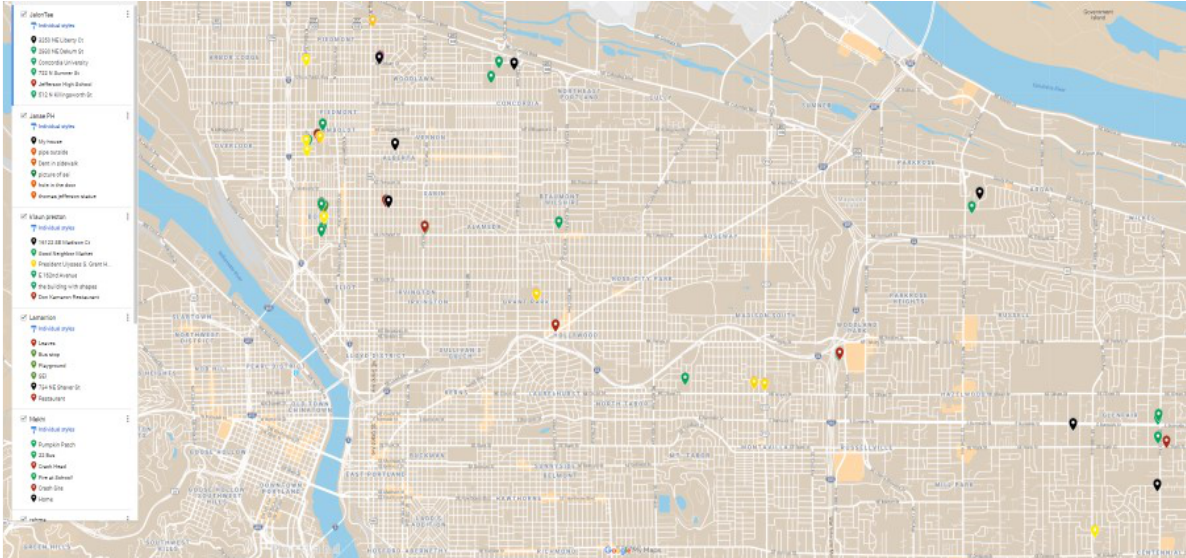
Figure 3. X-ray Mapping example produced by a youth researcher describing where and how place-based SDH affect their body.